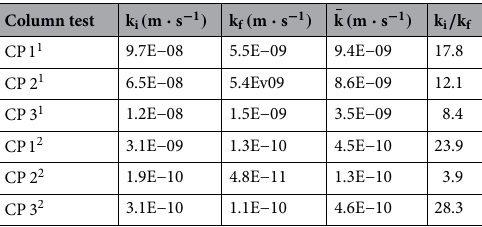
¯ k and final, k f soil permeability and k i / k f ratios. 1,2 Samples from first and second Table 5. Initial, k i , average, sampling